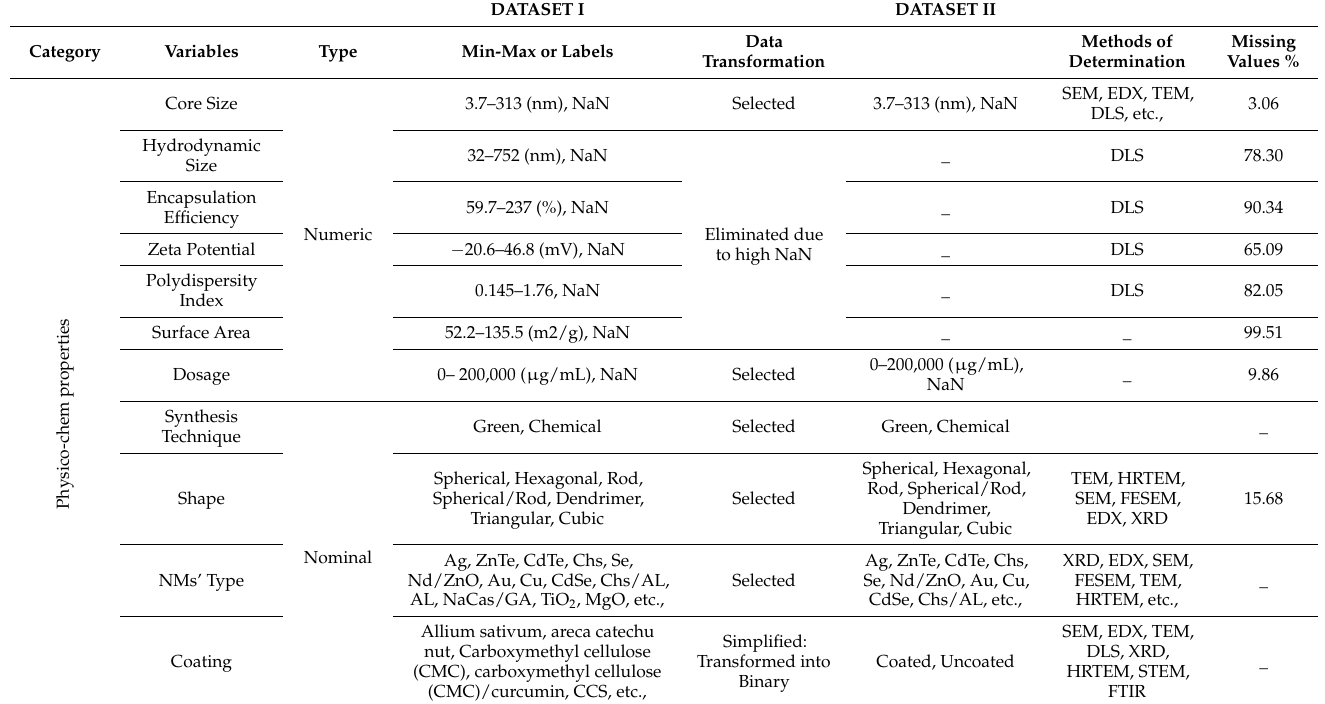
Table 1. The primary and final input variables in dataset I and dataset